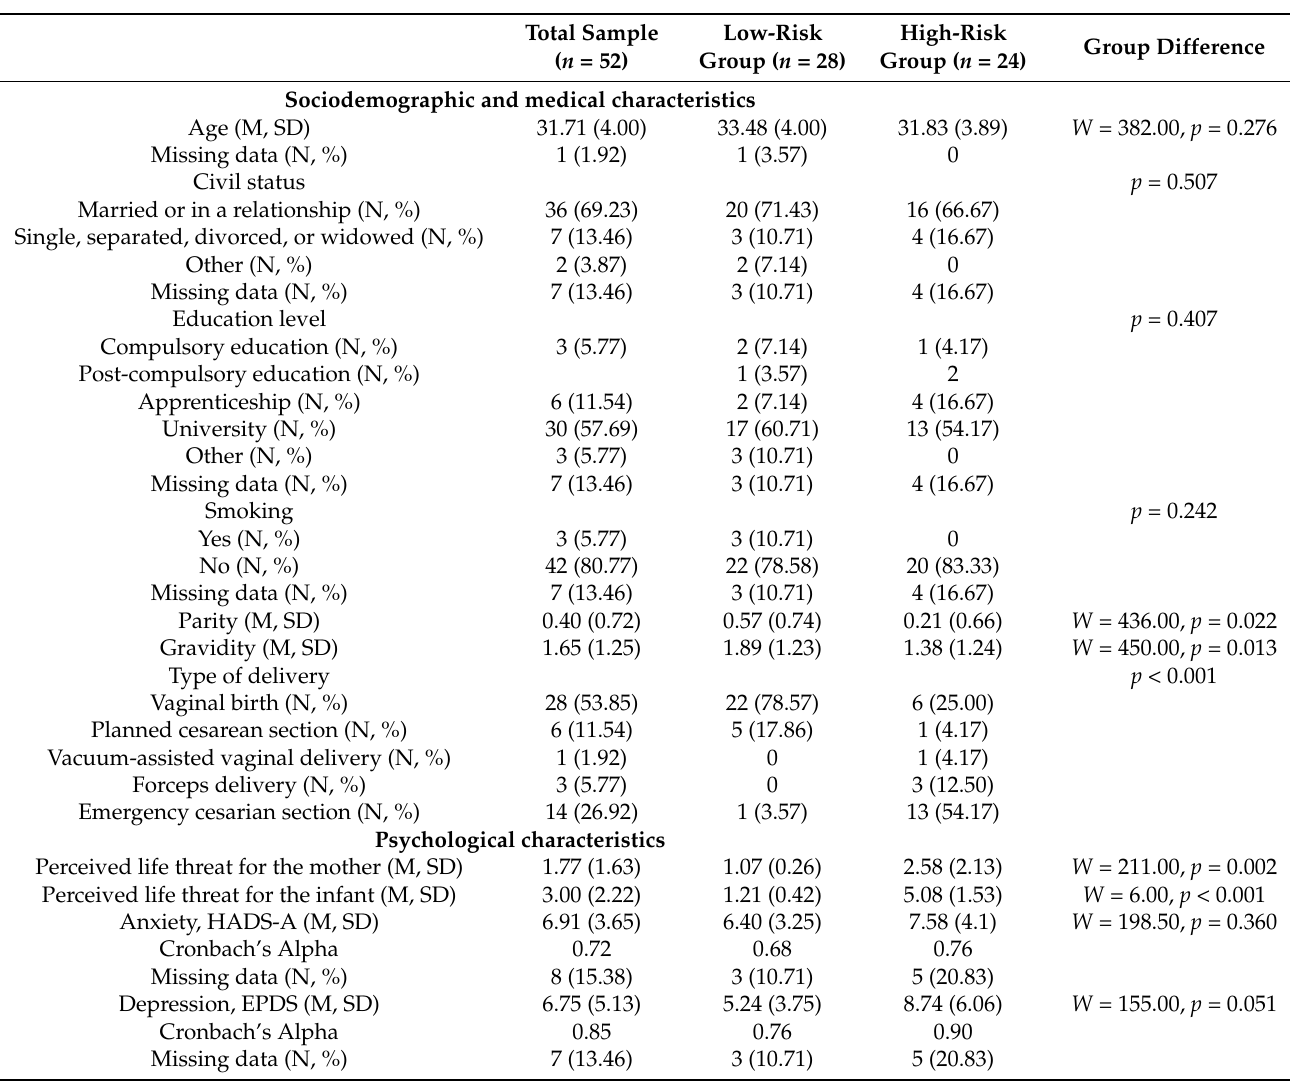
Table 2. Descriptive data of the